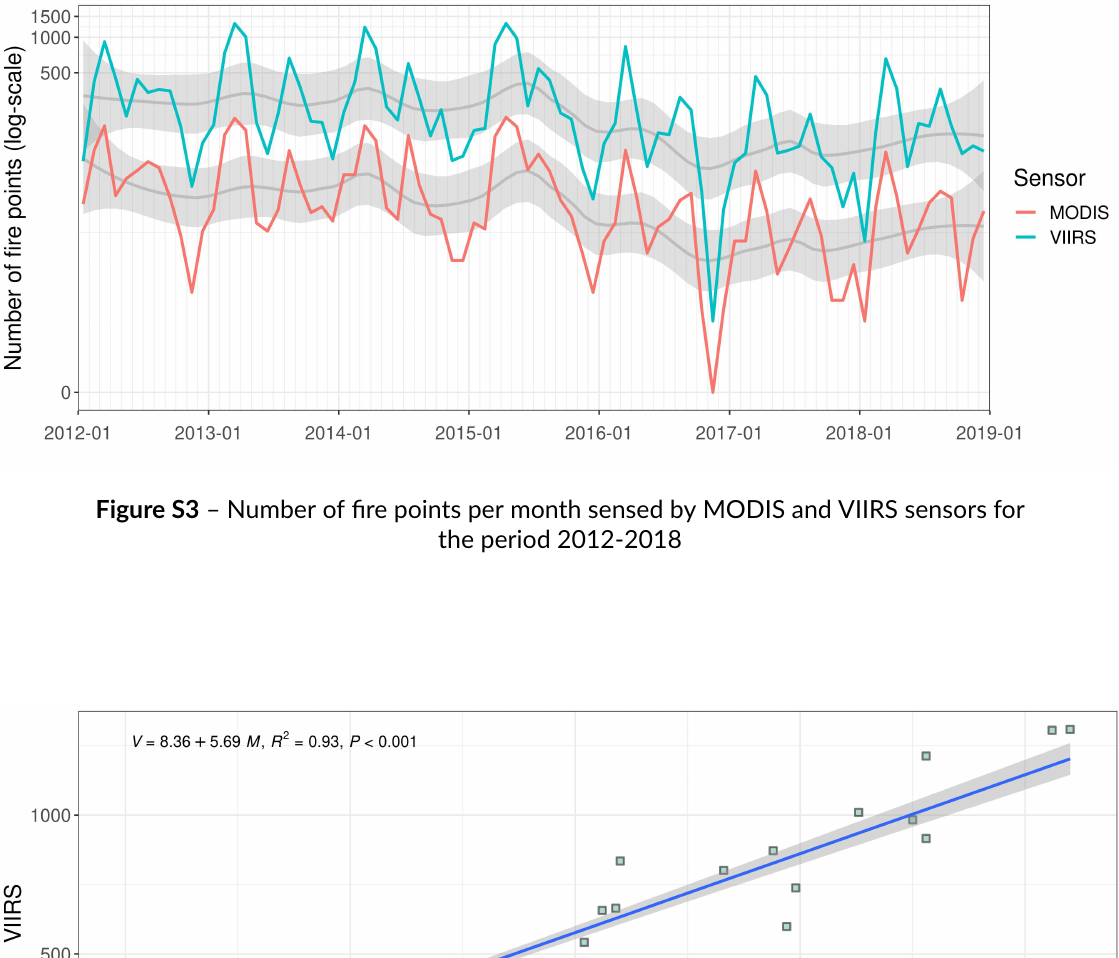
Long-term approach.